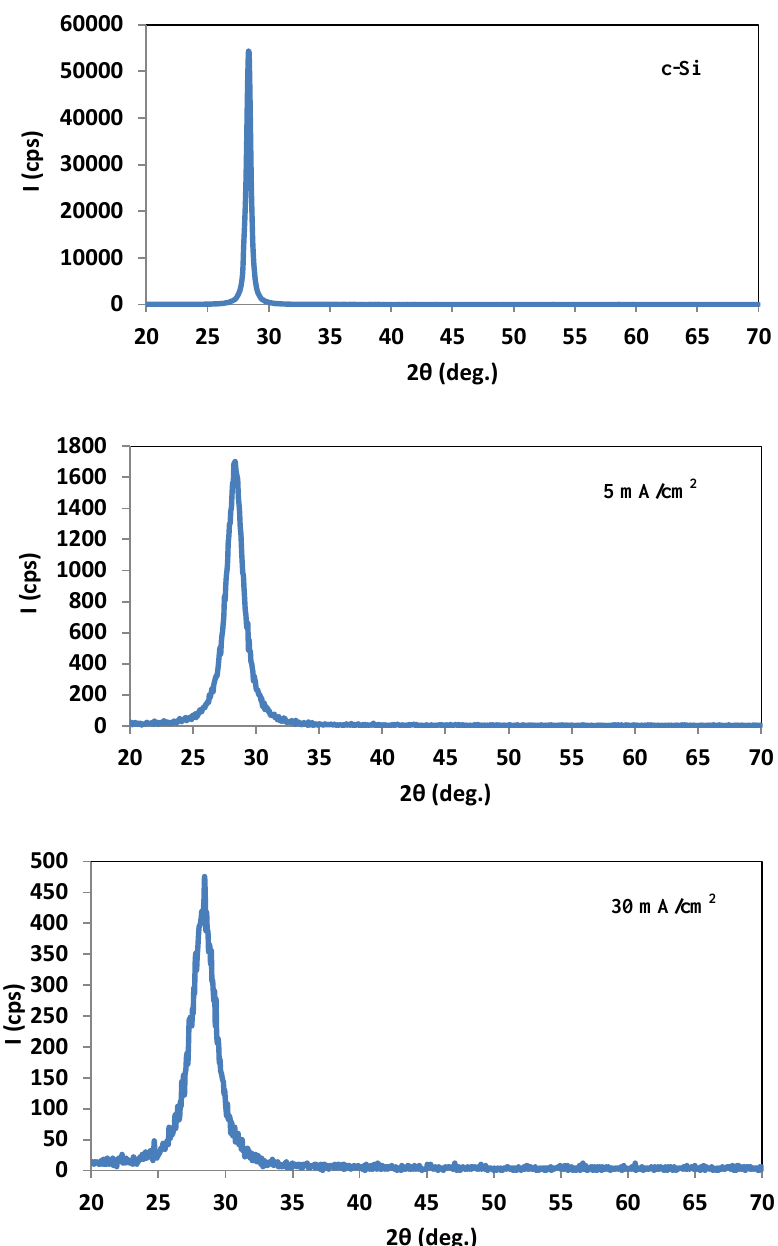
Fig. 4: XRD pattern of c-Si and PS layer prepare at J = 5 and 30 mA/cm 2 respectively etching time was 15 min and the HF concentration was